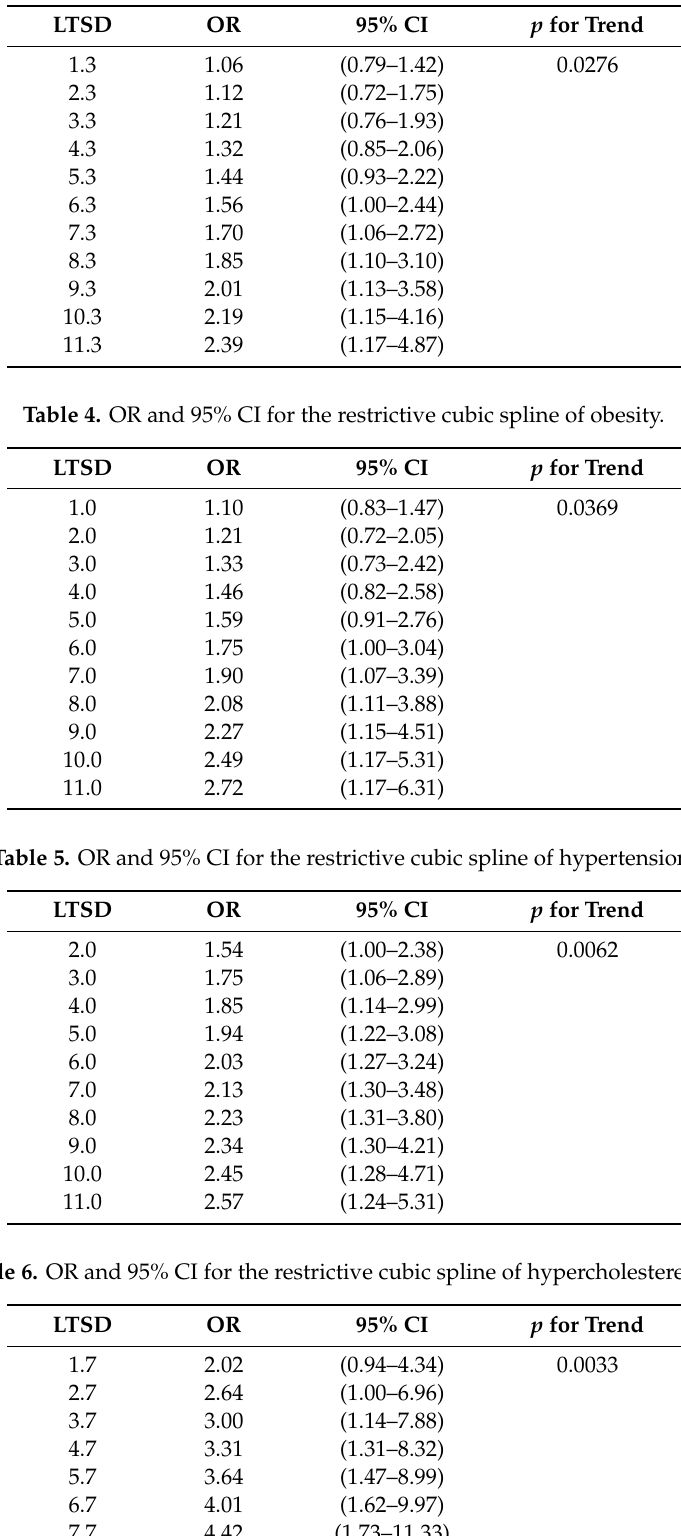
Table 3. Odds ratio (OR) and 95% confidence interval (CI) for the restrictive cubic spline of MetS.